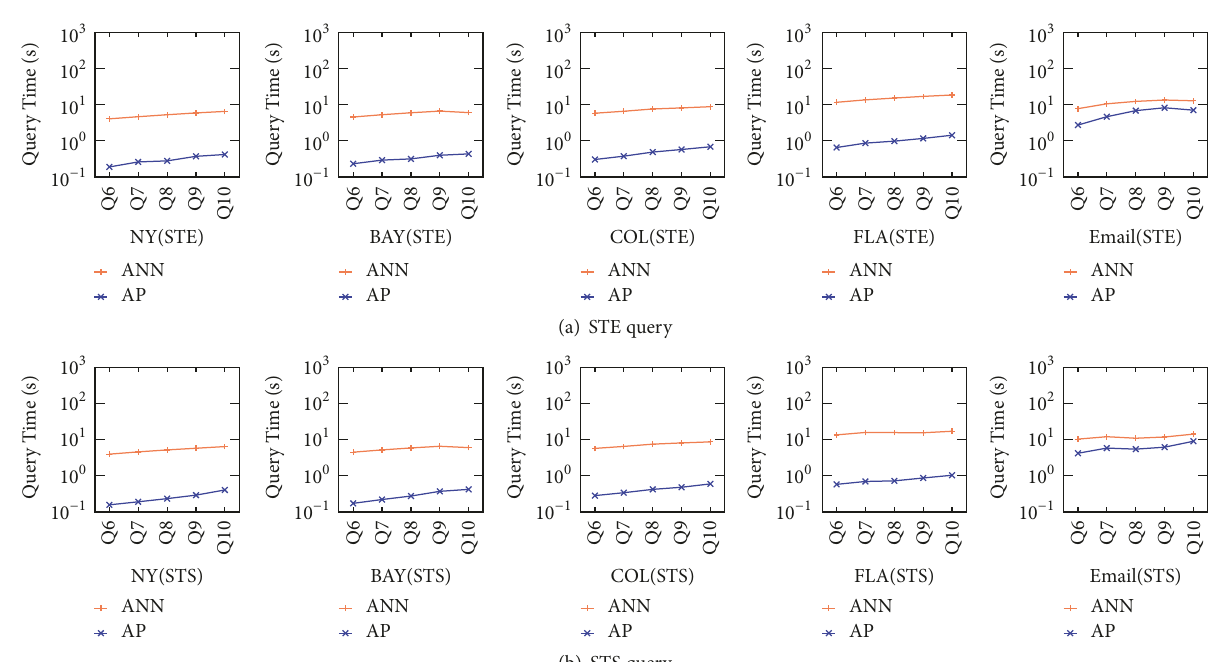
Figure 5: Query efficiency on